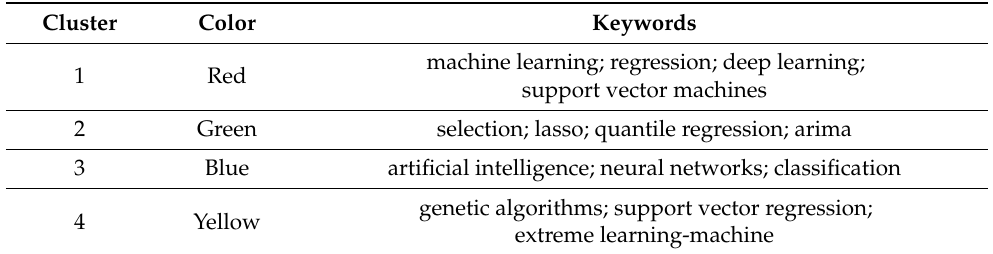
Table 3. Clusters of keywords co-occurrences as visible in Figure 3 for